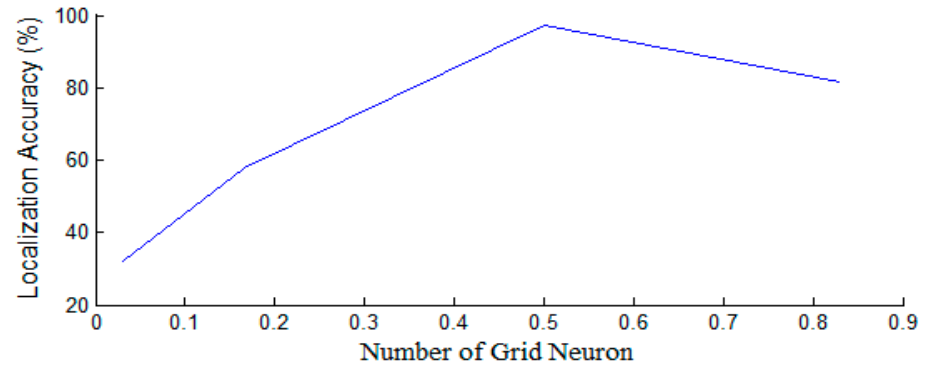
Figure 25. E ff ect of grid neuron population on Figure 25. Effect of grid neuron population on localization.